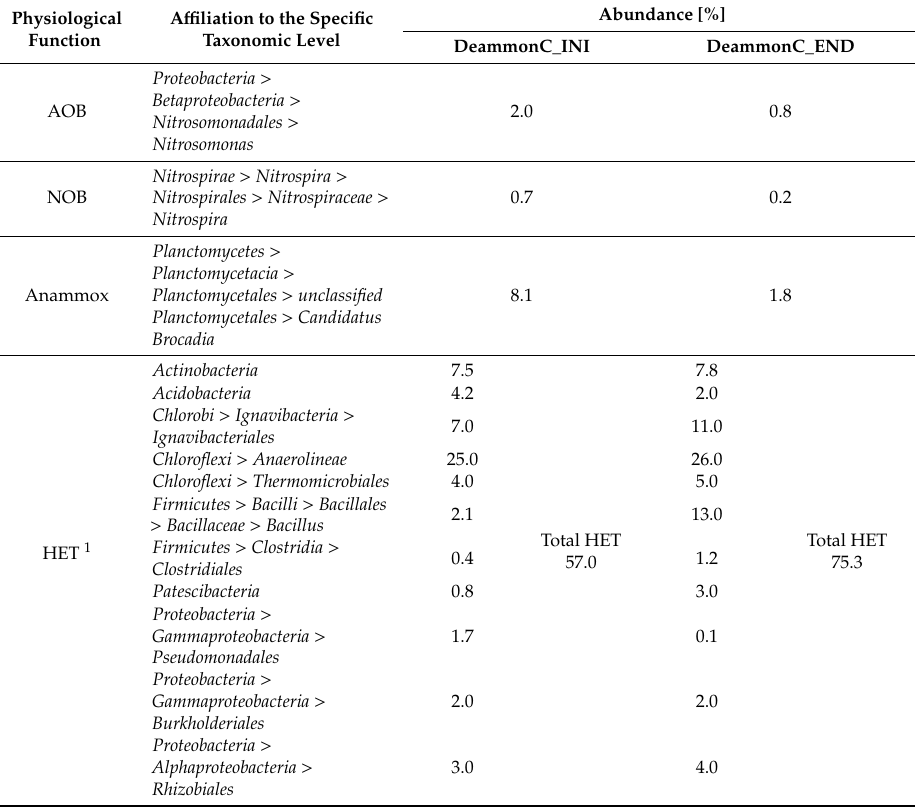
Table 3. Phylogenetic a ffi liation and percent abundances of the dominant representatives of basic physiological bacterial groups in the initial (INC) and biomass after end of the experiment with carbon dosage